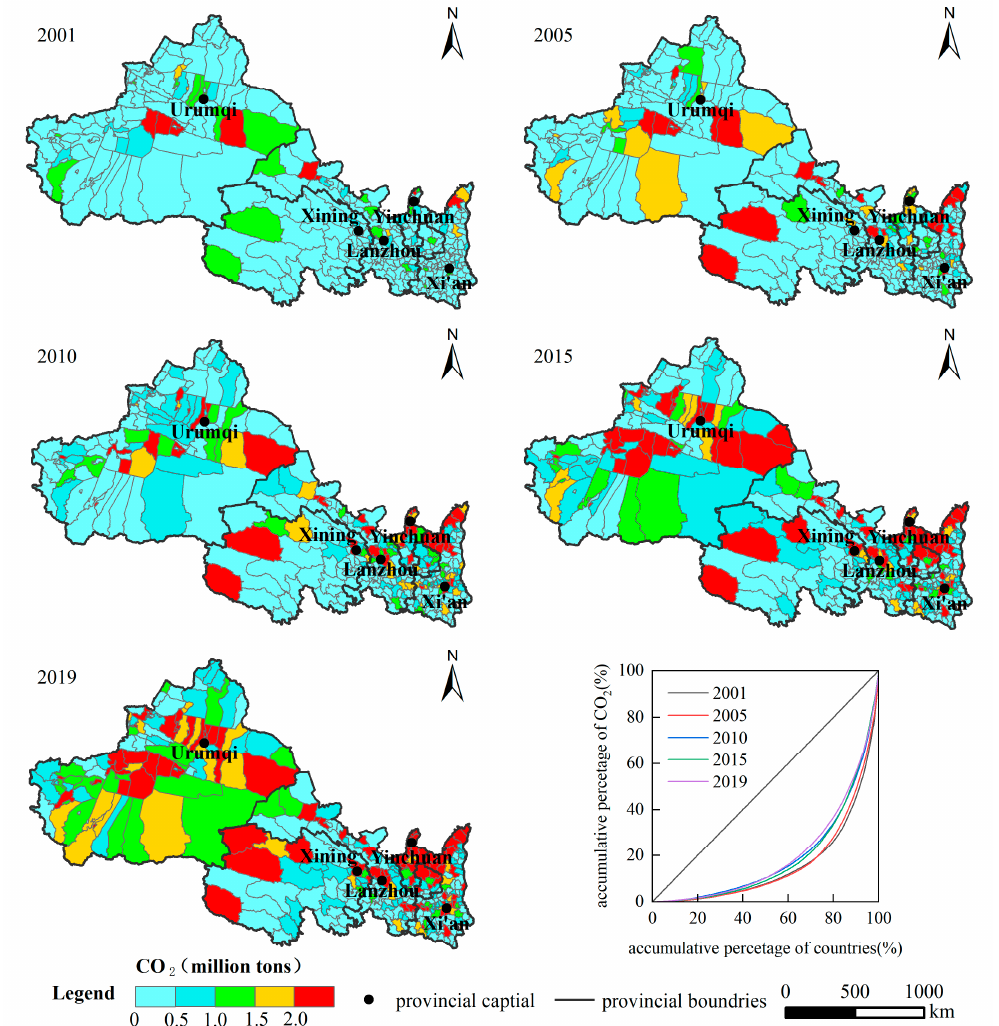
Figure 5. Spatial distribution of CE in northwest China at the country level from 2001 to 2019.